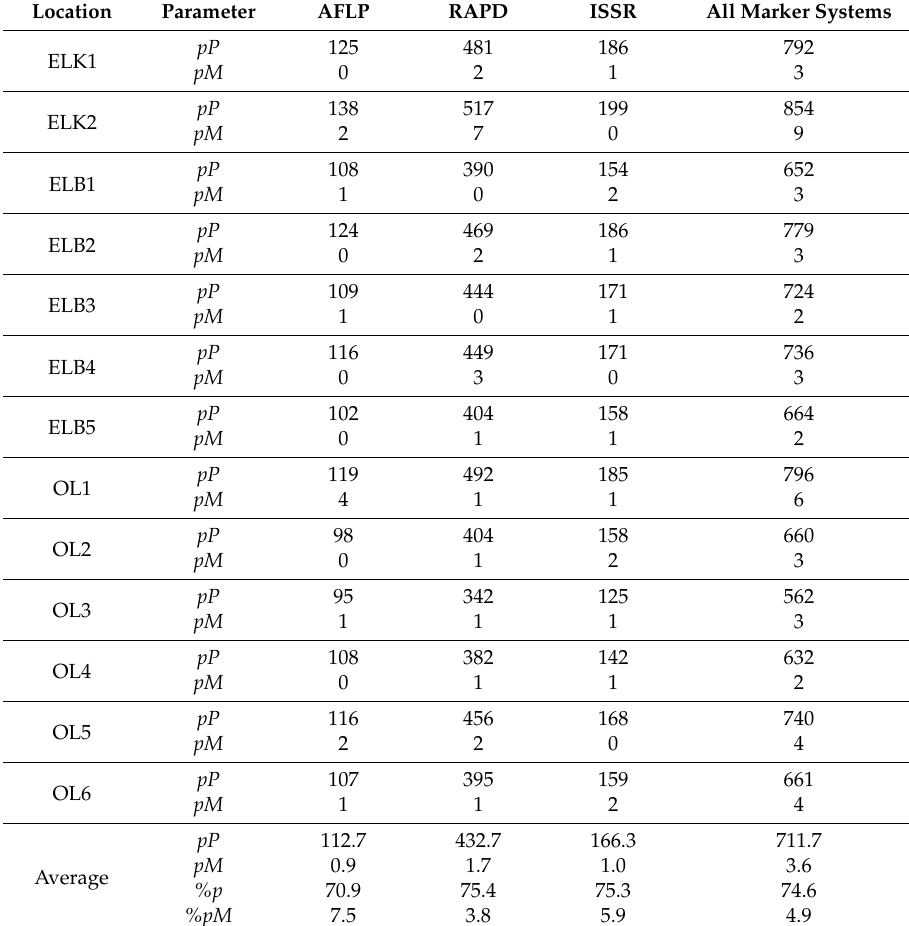
Table 2. Polymorphic ( pP ) and private amplification products ( pM ) for the analyzed locations of S. purpurea